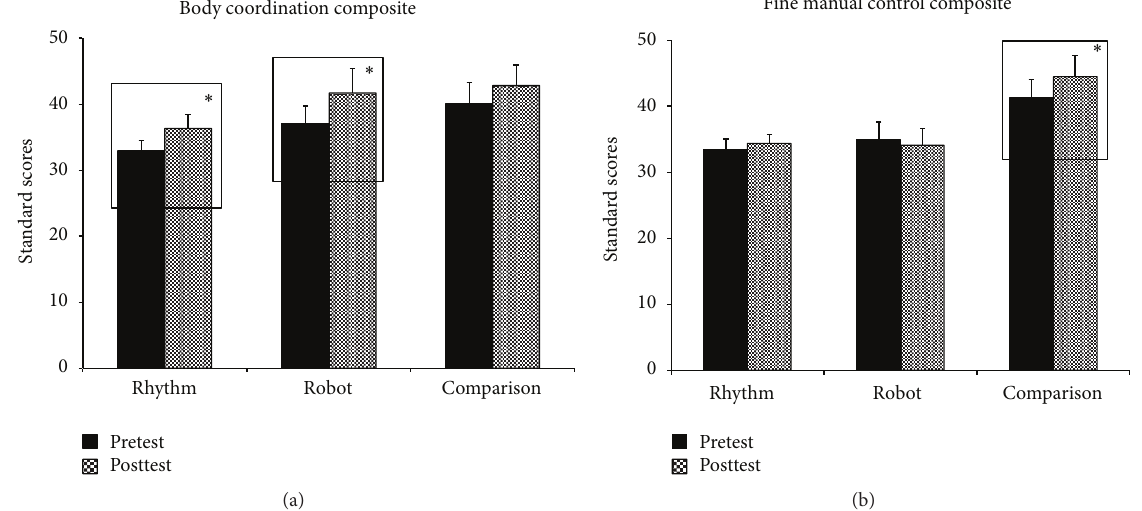
Figure 3: (a) Training-related changes on the body coordination composite of BOT-2. Error bars represent standard errors. (b) Training- related changes on the fine manual control composite of BOT-2. Error bars represent standard errors. ∗ 𝑝 ≤ 0.05 .